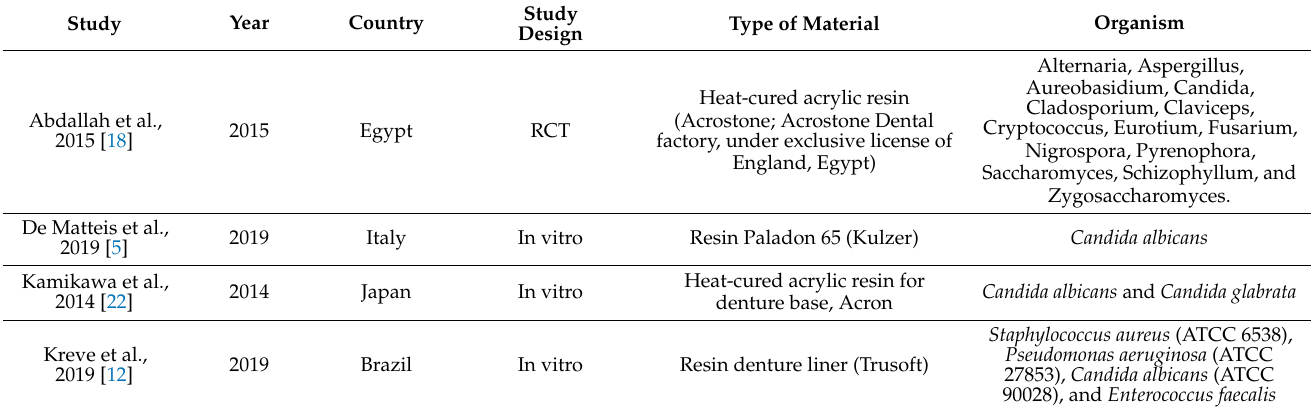
Table 1. Descriptive details of included